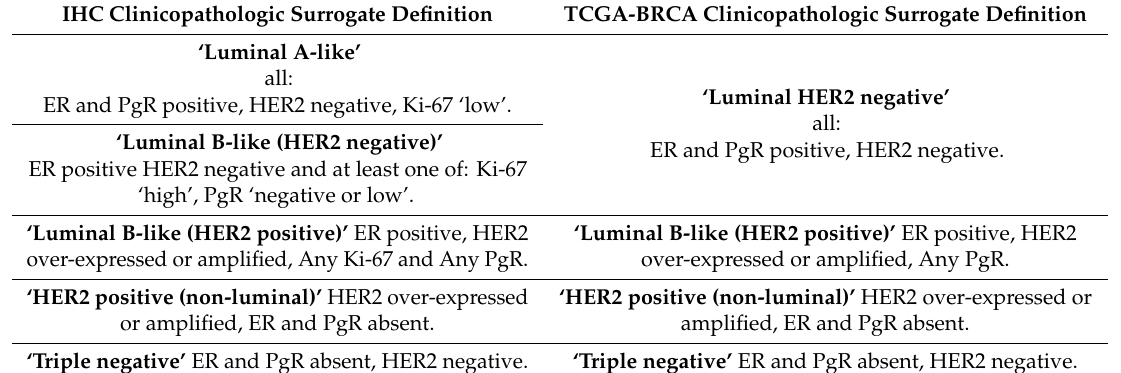
Table 2. Definition of clinical IHC and The Cancer Genome Atlas (TCGA)-BRCA breast cancer